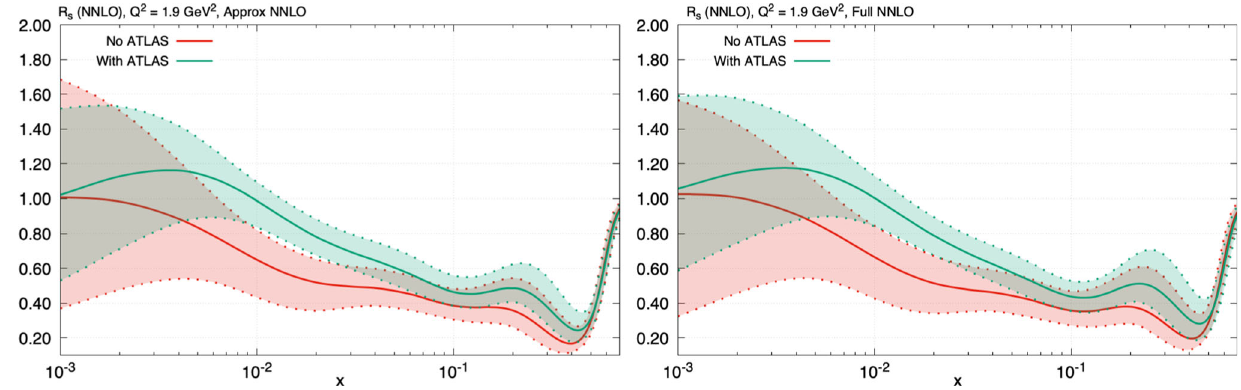
Fig. 55 Thestrangenessratio R s = ( s + s )/( u + d ) ,at Q 2 = 1 . 9GeV 2 , forvariantsoftheMSHTNNLOfits( α S free).Theresultoftheprevious approximate NNLO theory, and the full NNLO theory for the dimuon